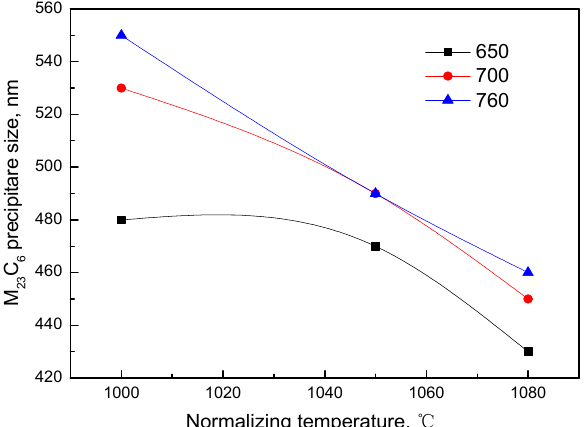
Figure 9. Average M 23 C 6 particle size at grain boundaries with variation in normalizing temperature.